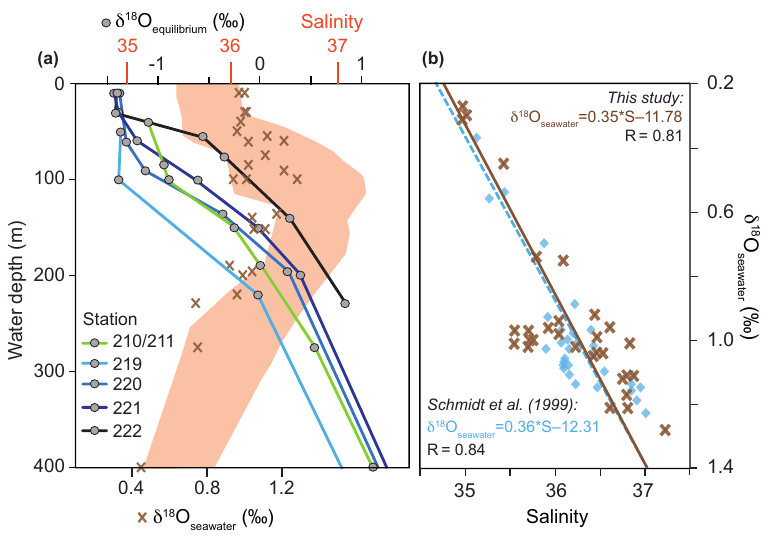
Figure 3. (a) δ 18 O seawater (‰ VSMOW) and colour-coded δ 18 O equilibrium (‰ PDB) depth profiles at the CTD stations 210/211, 219, 220, 221 and 222 (see Fig. 1). Red shading indicates the salinity envelope of the ambient seawater from the Florida Straits and Caribbean Sea measured during cruise M78/1 matching δ 18 O seawater . (b) Brown crosses indicate measured in situ salinity vs. δ 18 O seawater in the Caribbean Sea and Florida Straits in the upper 600m of the water column (see Sect. S1 for data); blue squares indicate salinity vs. δ 18 O seawater from Schmidt et al. (1999; Global Seawater Oxygen-18 Database) in the upper 600m of the water column in the Caribbean